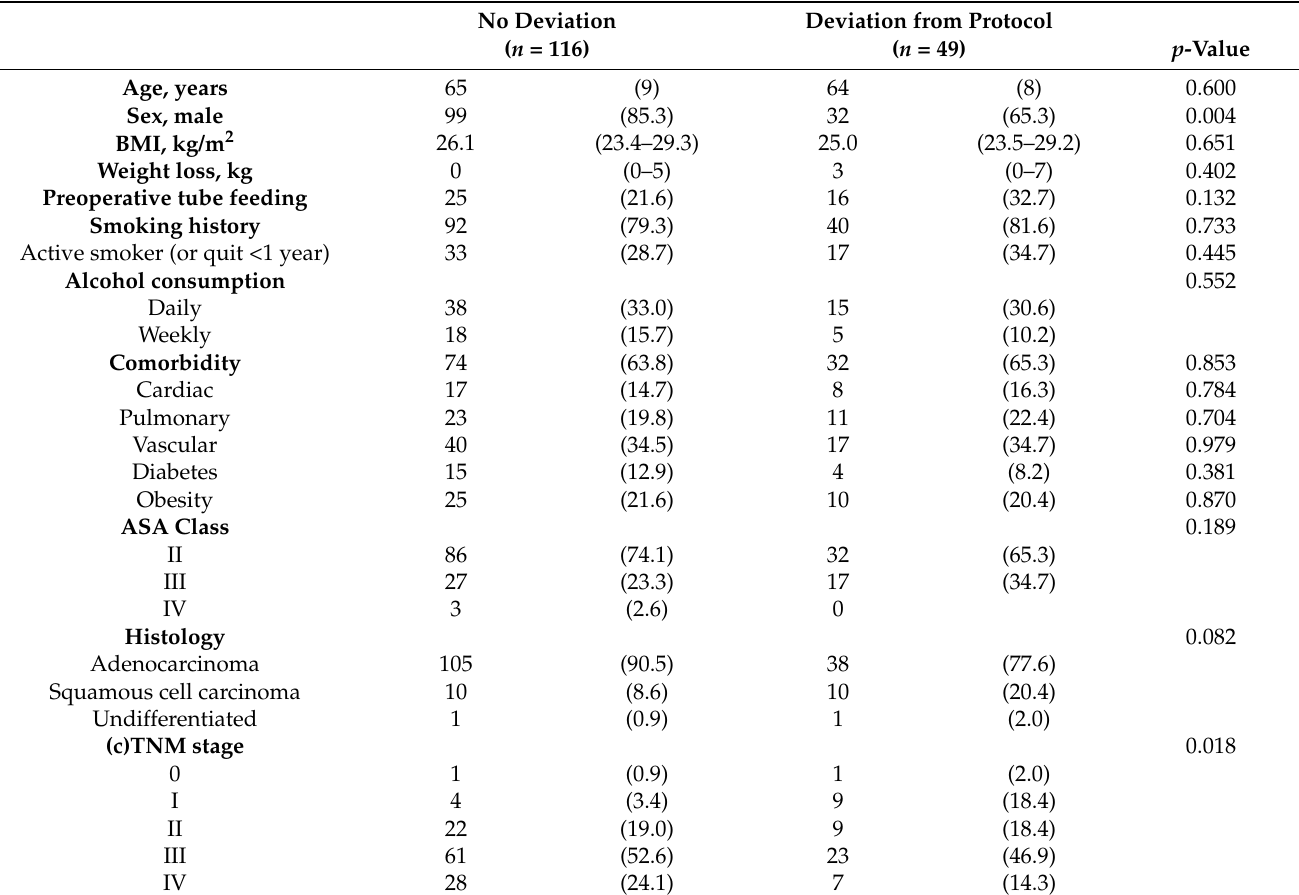
Table 1. Preoperative patient baseline characteristics by adherence to feeding